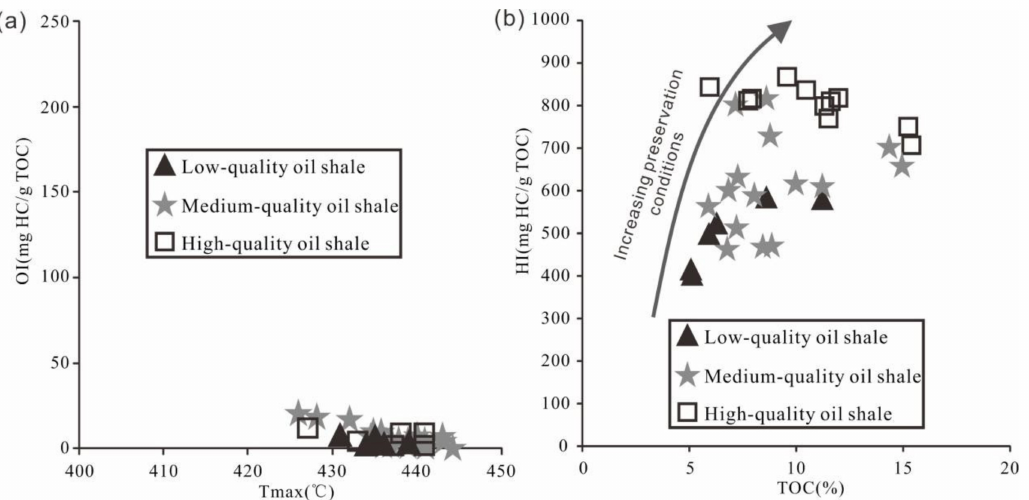
Figure 10. Relationships of ( a ) Tmax versus oxygen index (OI), and ( b ) total organic carbon (TOC) content versus hydrogen index (HI) for the different quality oil shales in the Shale Member of the Shimengou